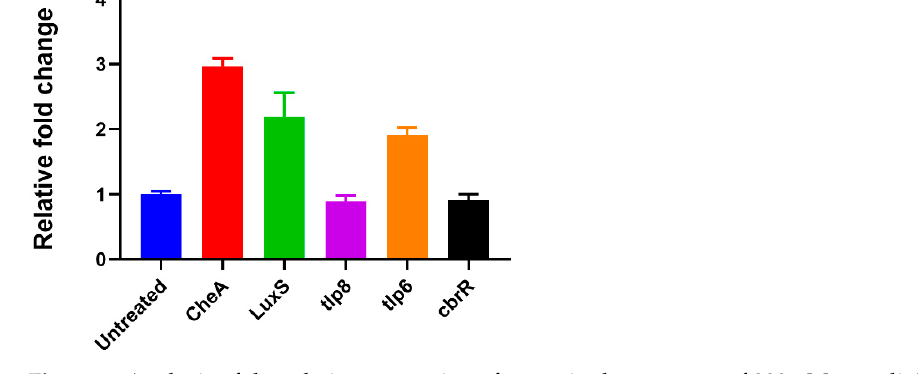
Figure 7. Analysis of the relative expression of genes in the presence of 200 μ M ex-c-di-GMP. The expression of tlp6 , tlp8 , luxS cheA and cbrR genes relative to housekeeping gene gryA after incubation of C. jejuni 11168-O cells with 200 μ M ex-c-di-GMP for 3 h.